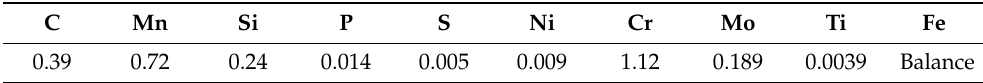
Table 1. Chemical composition of experimental 42CrMo steels (wt.%).